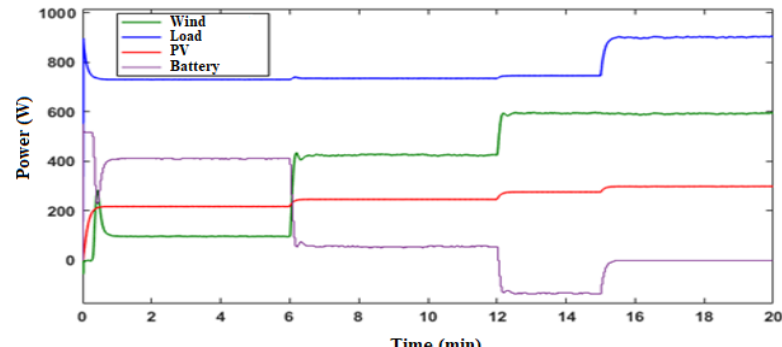
Figure 18. Power delivered by the MSPS.